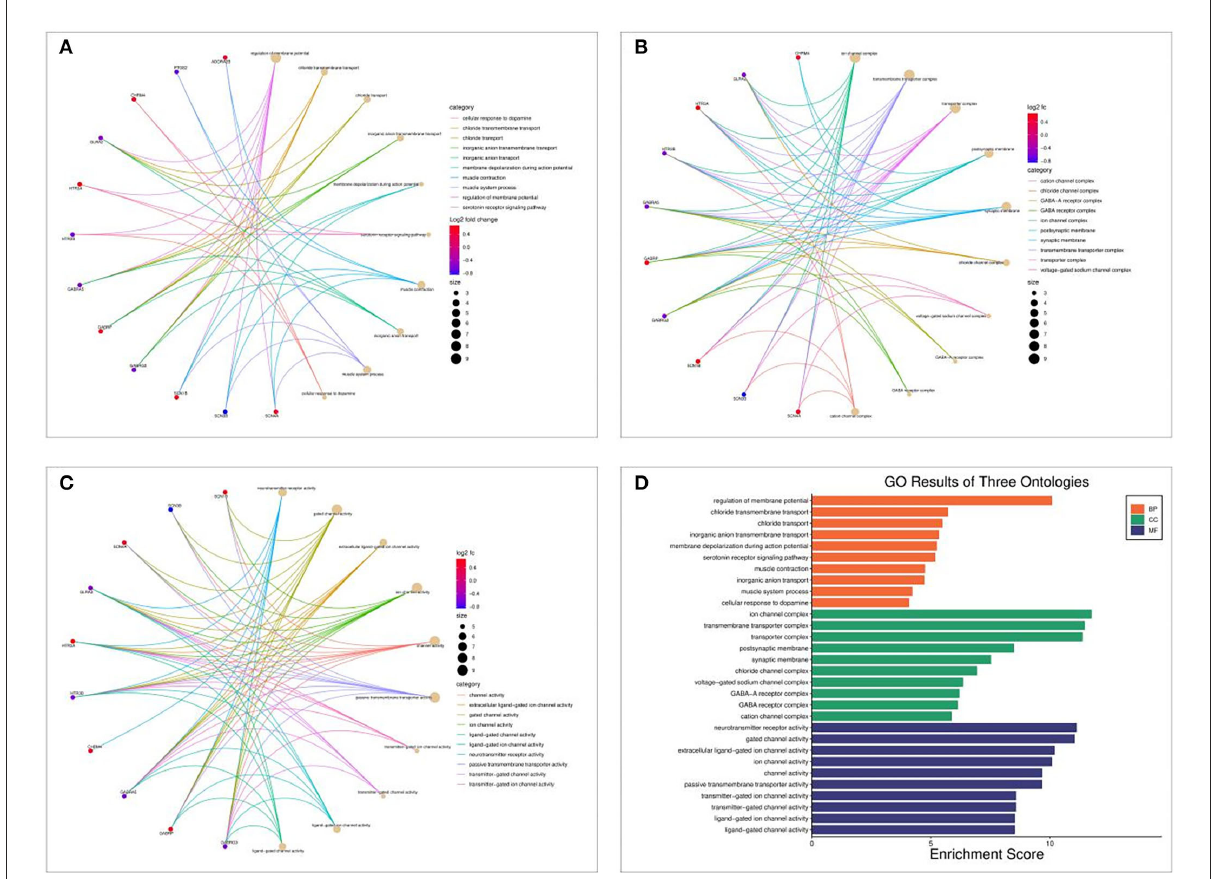
FIGURE5 GO enrichment analysis of 18 potential targets of Shunaoxin pill for the treatment of cognitive impairment in patients with type 2 diabetes. (A) BP functional analysis chord diagram. (B) CC functional analysis chord diagram. (C) MF functional analysis chord diagram. (D) GO enrichment analysis histogram.